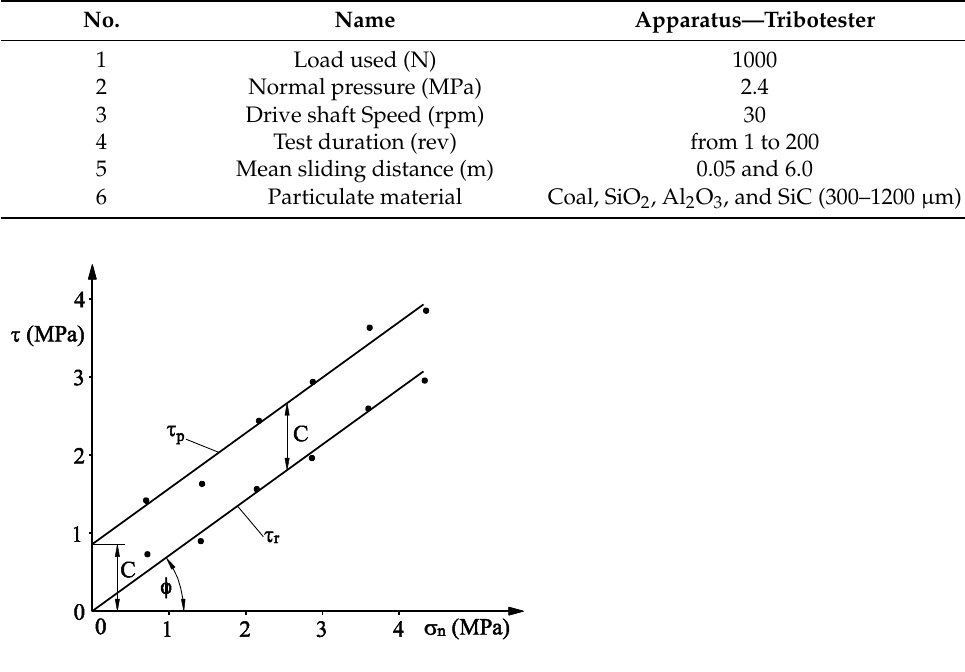
Figure 7. Shear strength of fine coal in a function of normal stress, and Coulomb’s parameters ϕ and C (Equation (3)).